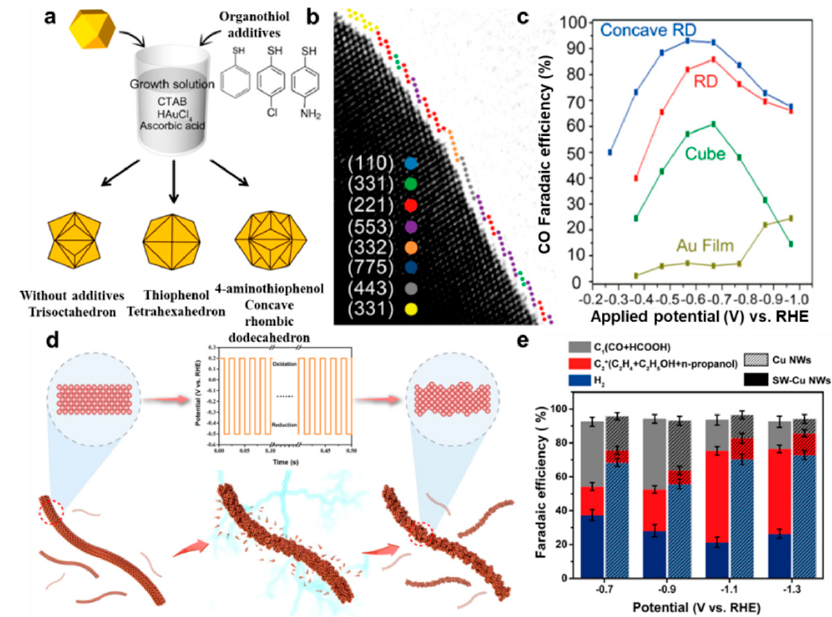
Figure 10. ( a ) Surface control of Au nanocrystals by capping agent. ( b ) HRTEM image showing the surface structure of a concave rhombic dodecahedral Au nanocrystal. ( c ) FE of CO for Au catalysts with shapes of film, cube, rhombic dodecahedron (RD) and concave rhombic dodecahedron. Reproduced with permission [80]. Copyright 2015, American Chemical Society. ( d ) Schematic illustration showing surface structure change of Cu nanowires by square–wave potential. ( e ) FE of products on perfect and square–wave potential treated–Cu nanowires (SW–Cu NWs). Reproduced with permission [81]. Copyright 2022,